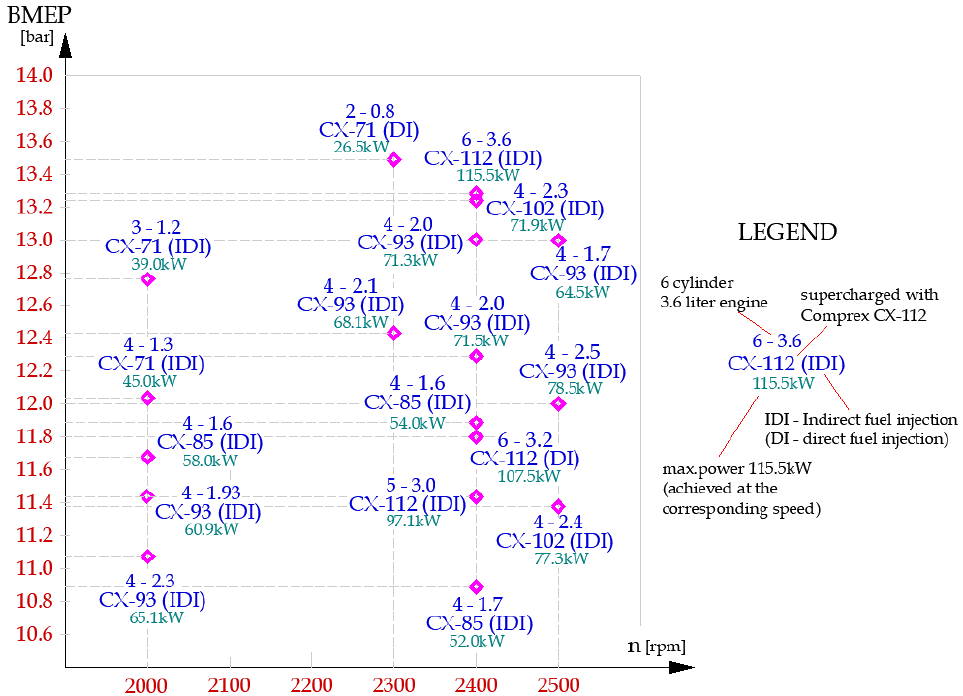
Figure 5. Max. output power for 5 CX models and engine configurations (with CAC). Made based on [23].